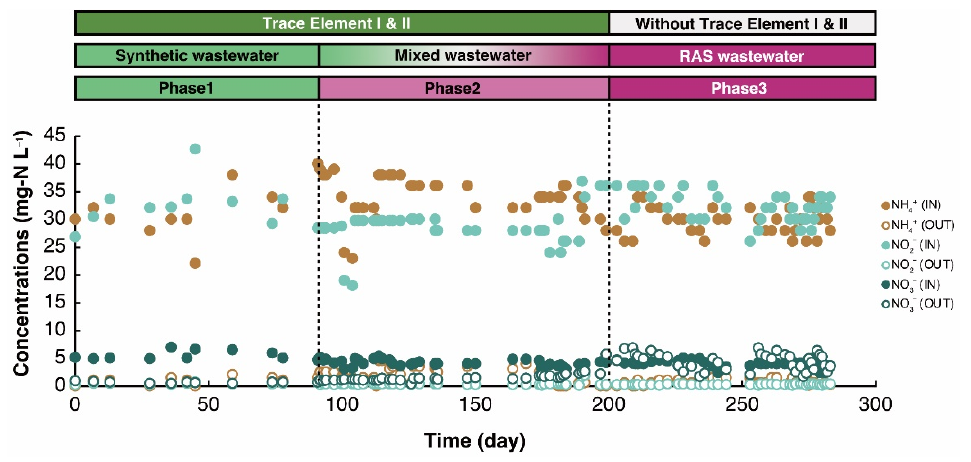
Figure 3. Concentration of NH 4+ , NO 2 − and NO 3 − in the influent (filled circles) and effluent (open circles) throughout the experiment.